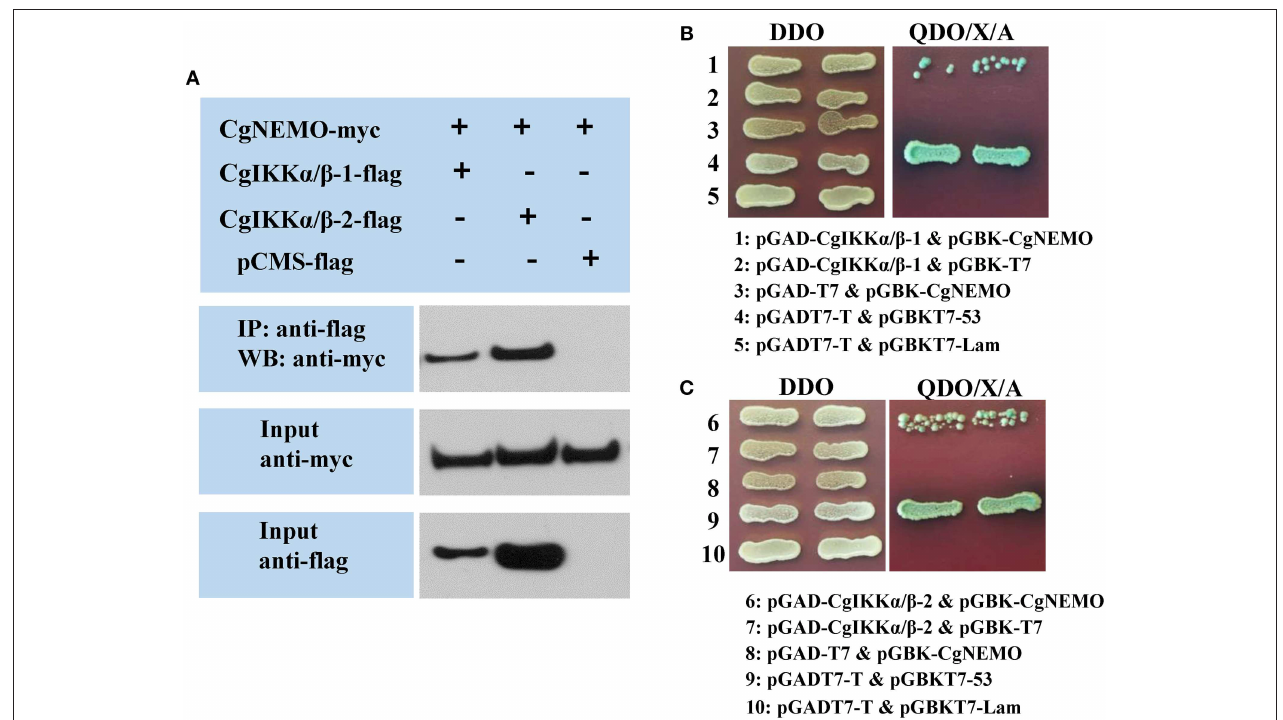
FIGURE 8 | Oyster NEMO interacts with both CgIKK α / β -1 and CgIKK α / β -2. (A) Co-IP results showing that CgNEMO directly interacts with CgIKK α / β -1 and CgIKK α / β -2. Anti-Myc western blot bands show the expression of CgNEMO-Myc and anti-FLAG western blot bands show the expression of CgIKK α / β -1-FLAG and CgIKK α / β -2-FLAG. (B) Interaction between CgIKK α / β -1 and CgNEMO was confirmed by Y2H assay. (C) Interaction between CgIKK α / β -2 and CgNEMO was confirmed by Y2H